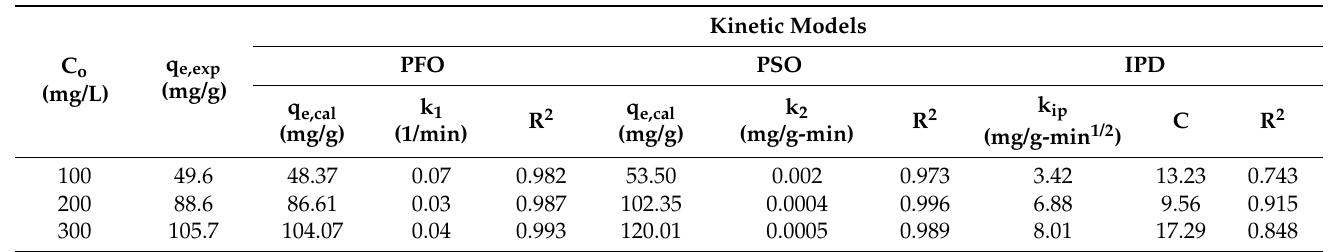
Table 3. Kinetic modeling parameters for MO adsorption on CHt@MgO.